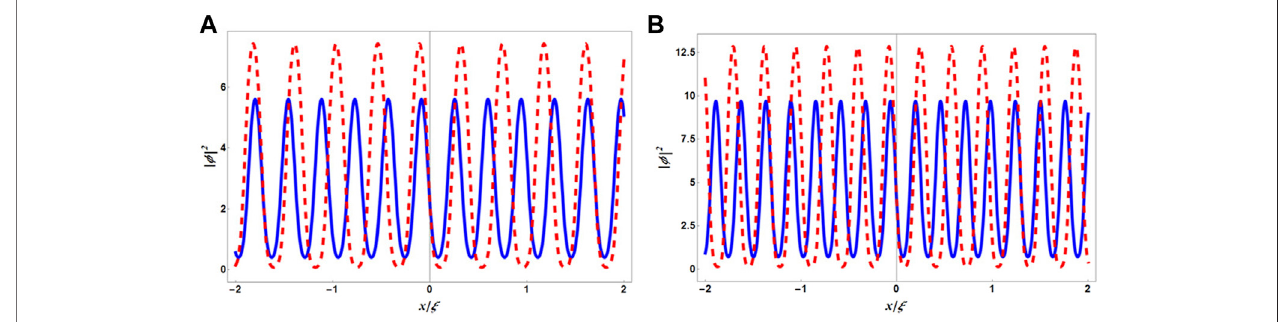
FIGURE12| (ColorOnline)Density pro fi lescorrespondingto Eq.33 fordifferentvaluesof g and q .Inboth thepanels, bluesolidlineandred dashed linearefor q = 0.2 and q = 0.5, respectively. (A,B) are prepared for g = 10 and g = 12, respectively. In both fi gures, δ g = 0.1 and | ϕ | 2 is scaled to 10 − 3